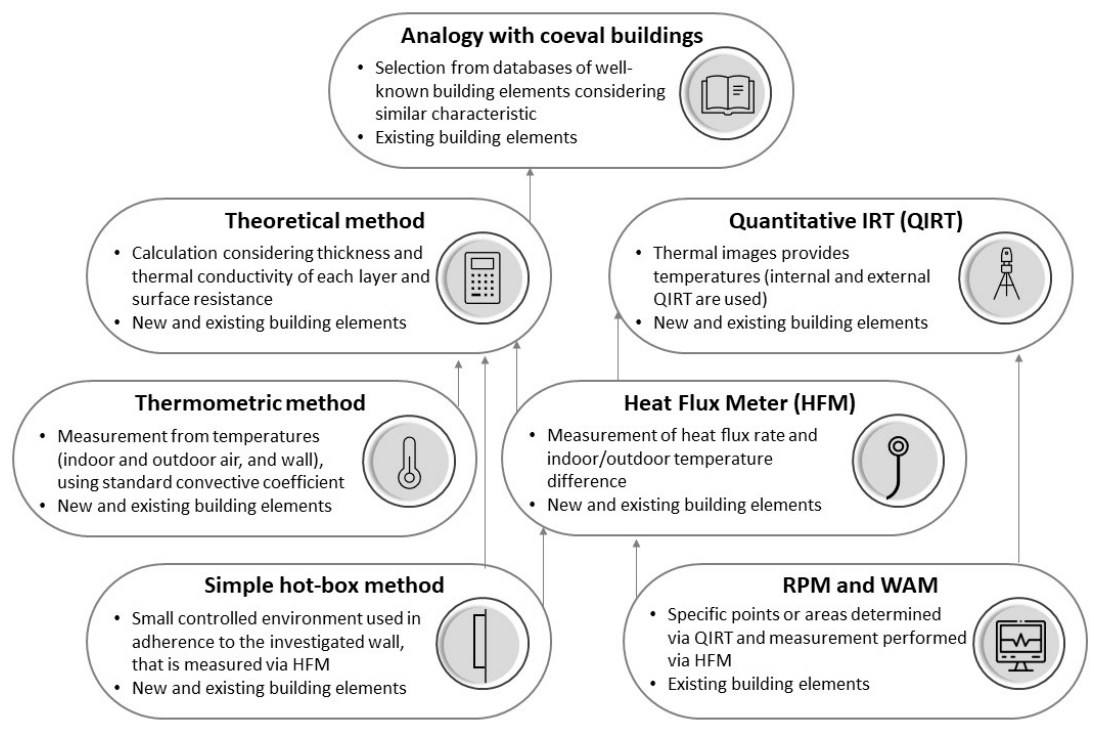
Figure 11. Methodology interconnections.